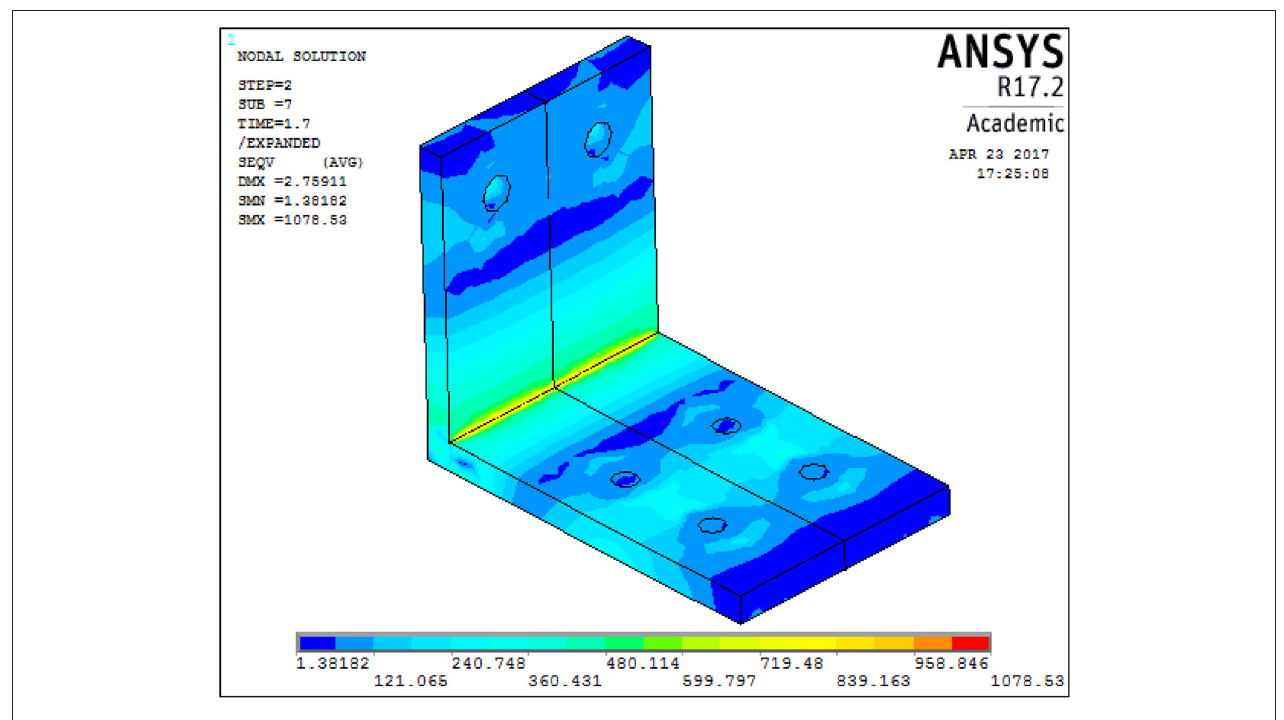
FIGURE 5 | Von Mises stress distribution in the top angle for case 1.